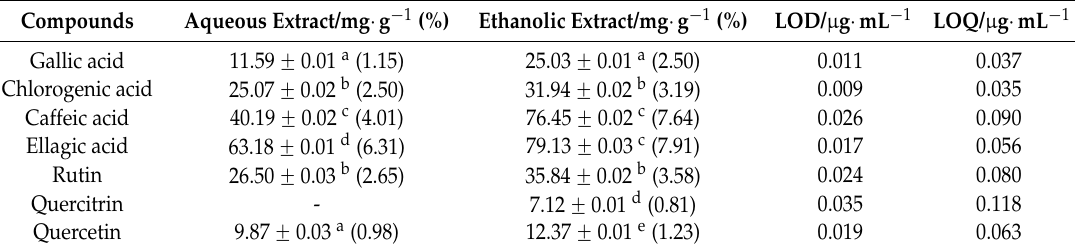
Table 2. Phenolics and flavonoids composition of R. echinus